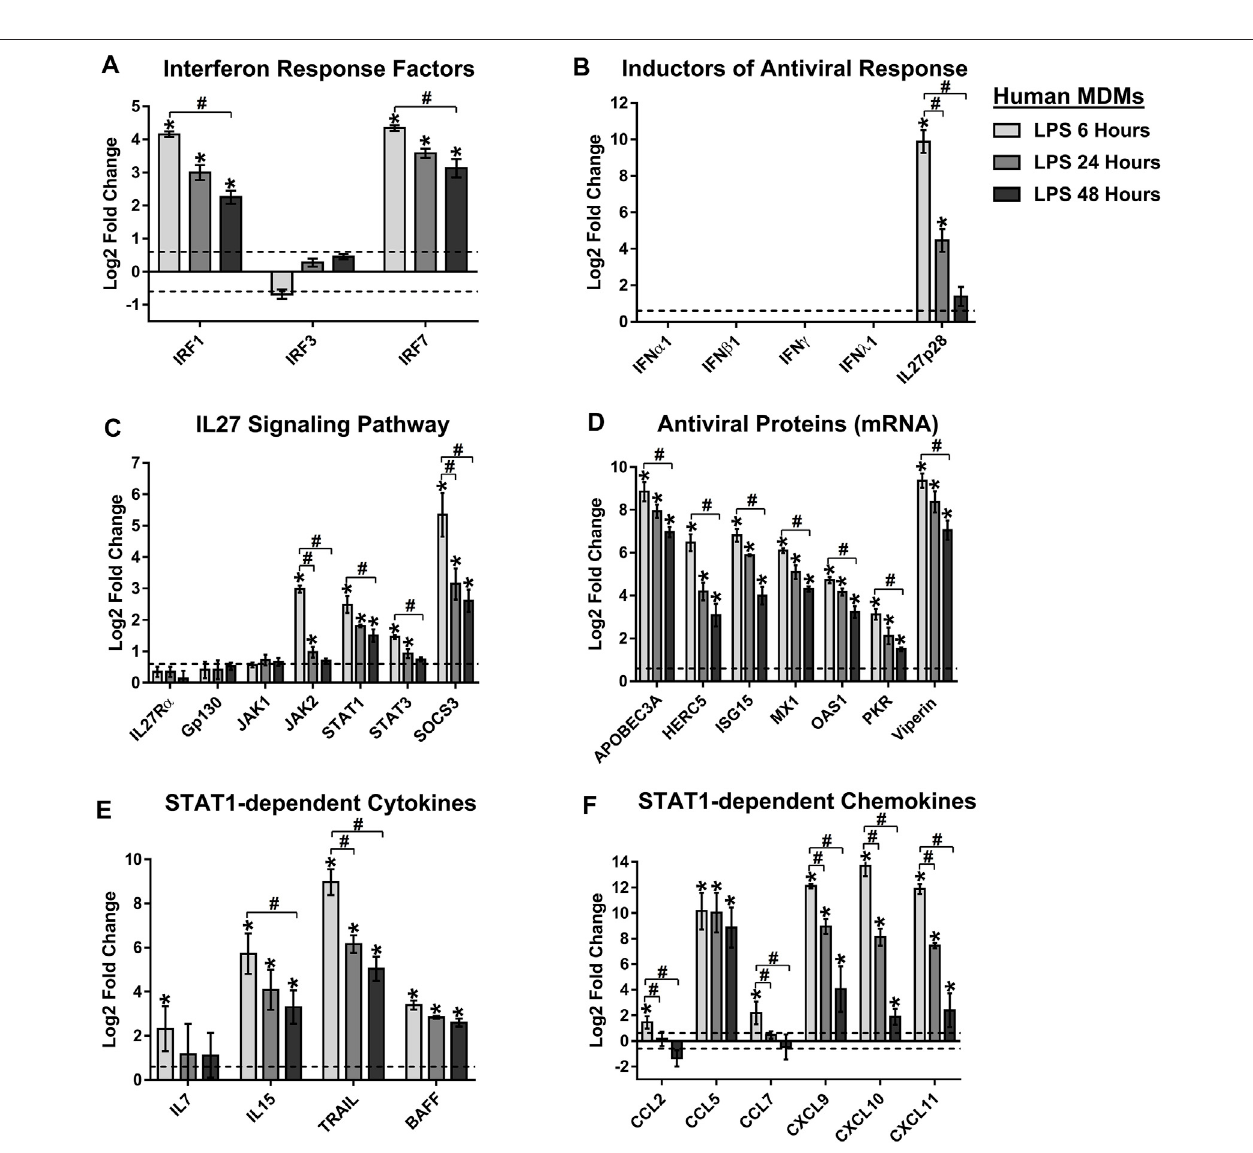
FIGURE 9 | TLR4 activation triggers the expression of IL27, which induces STAT1-dependent pro-in fl ammatory and antiviral responses in human MDMs. We reanalyzed a publicly available RNA-seq dataset [GSE84188 (GEO) (Olejnik et al., 2017)], obtained from human MDMs stimulated with 100 ng/ml of LPS, for 6, 24 or 48 h. Differentially expressed IRFs (A) , inductors of antiviral response (B) , IL27 signaling pathway components (C) , AVPs (D) , STAT1-dependent cytokines (E) , and STAT1-dependent CC- and CXC-chemokines (F) . Data are presented as the mean ± SEM. Kruskal – Wallis test with Dunn ’ s post-test was performed. Signi fi cant results between unstimulated and LPS-stimulated MDMs are de fi ned as p < 0.05 (*), p < 0.01 (**) and p < 0.002 (***). Signi fi cant results between treatment-times comparisons are de fi ned as p < 0.05 (#), p < 0.01 (##) and p < 0.002 (###).